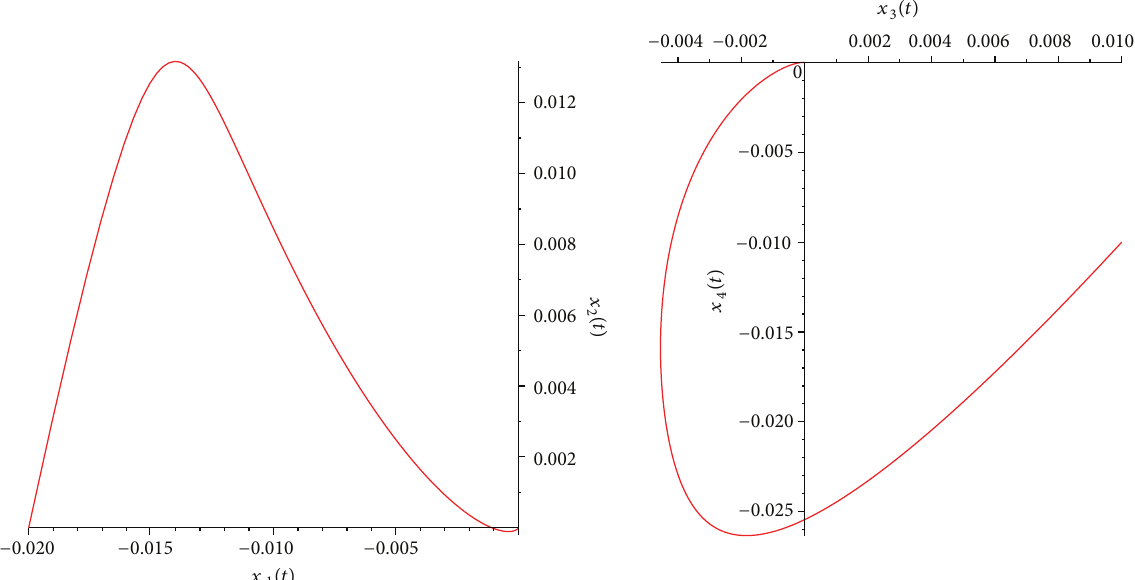
Figure 8: Trajectory projection starting from (𝑥 1 , 𝑥 2 ,𝑥 3 ,𝑥 4 ) = (−0.02, 0, 0.01, −0.01) converges to the E.S. when (𝜉 1 ,𝜉 2 ) = (0.1,0.2) .